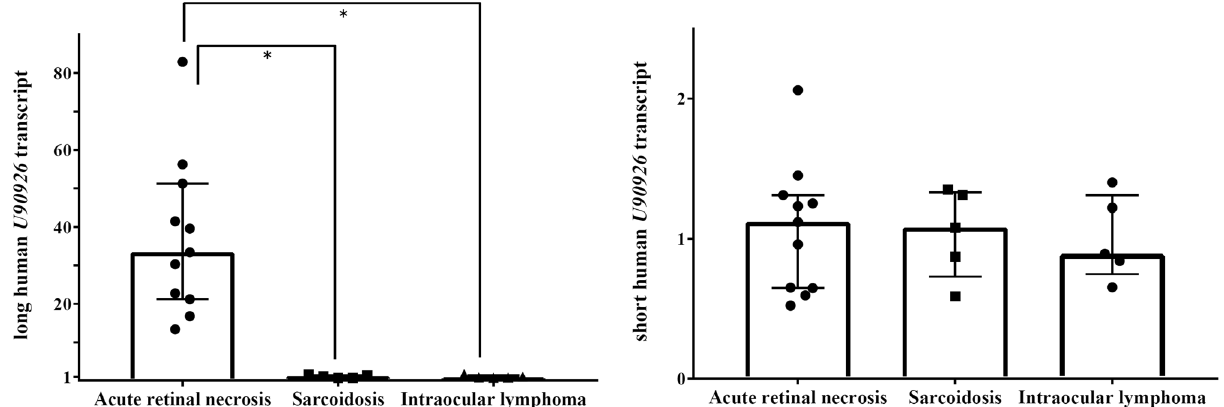
Figure 2. Expression levels of the long and short human U90926 transcripts in the vitreous fluid from patients with acute retinal necrosis, sarcoidosis, and intraocular lymphoma. A reverse transcription-quantitative real- time polymerase chain reaction analysis of the long (upper) and short (lower) human U90926 transcripts in the vitreous fluid of patients with acute retinal necrosis (n = 11), sarcoidosis (n = 5), and intraocular lymphoma (n = 5). Results are expressed as mean ± standard deviation. * p <